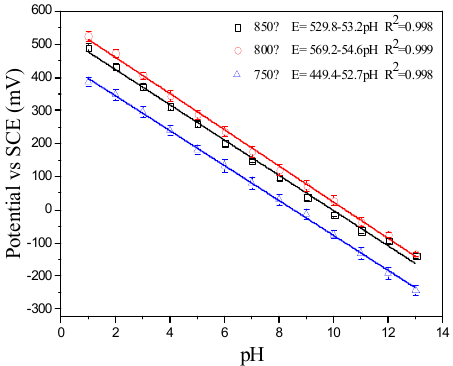
Figure 5. pH response characteristics of IrO X electrodes fabricated at di ff erent oxidation temperatures.